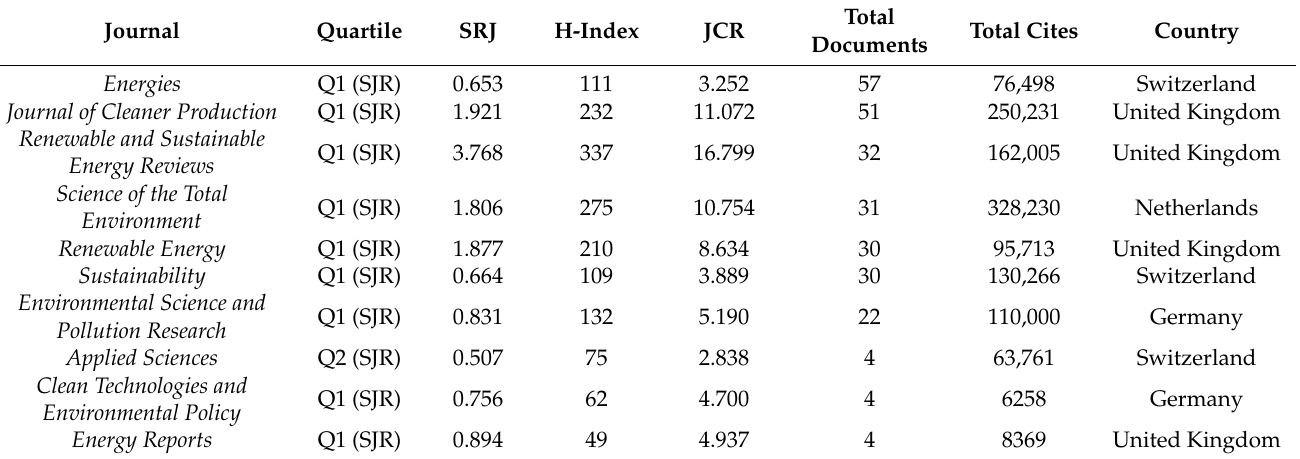
Figure 7. Documents published by subject area. Table 3. Top 10 journals in 2021 in terms of documents published on renewable energy and agricul-